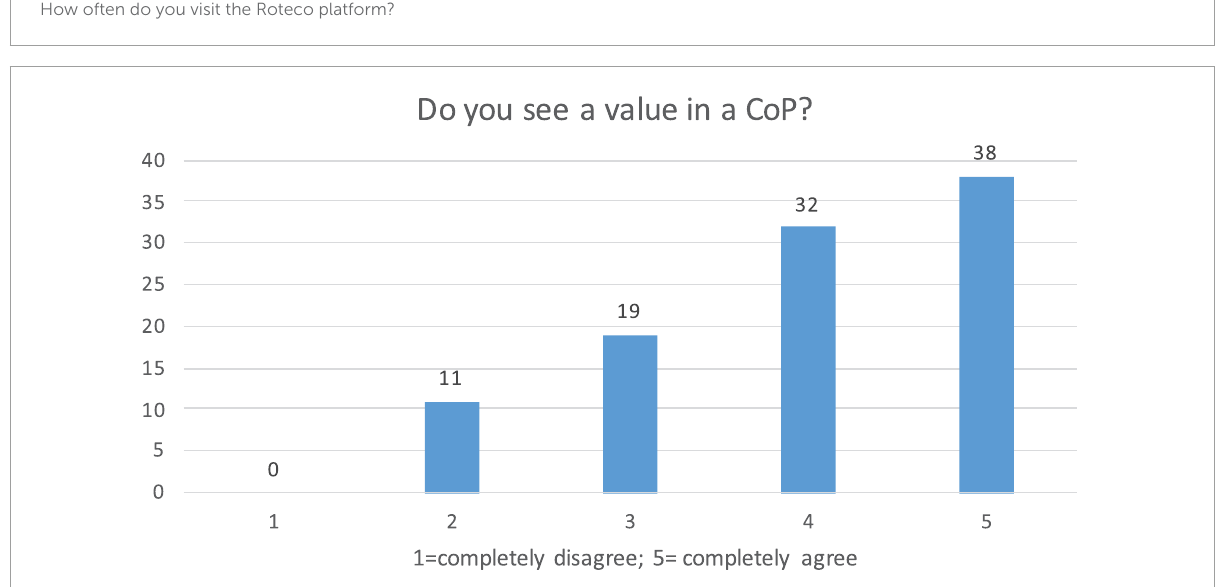
FIGURE3 How often do you visit the Roteco platform?